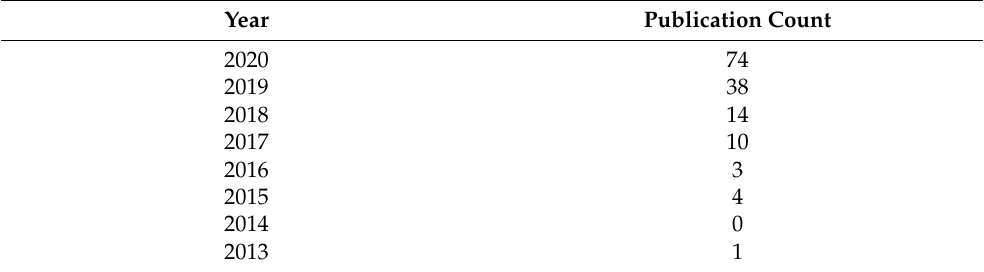
Table 4. Yearly publishing trends of IOT in crop disease